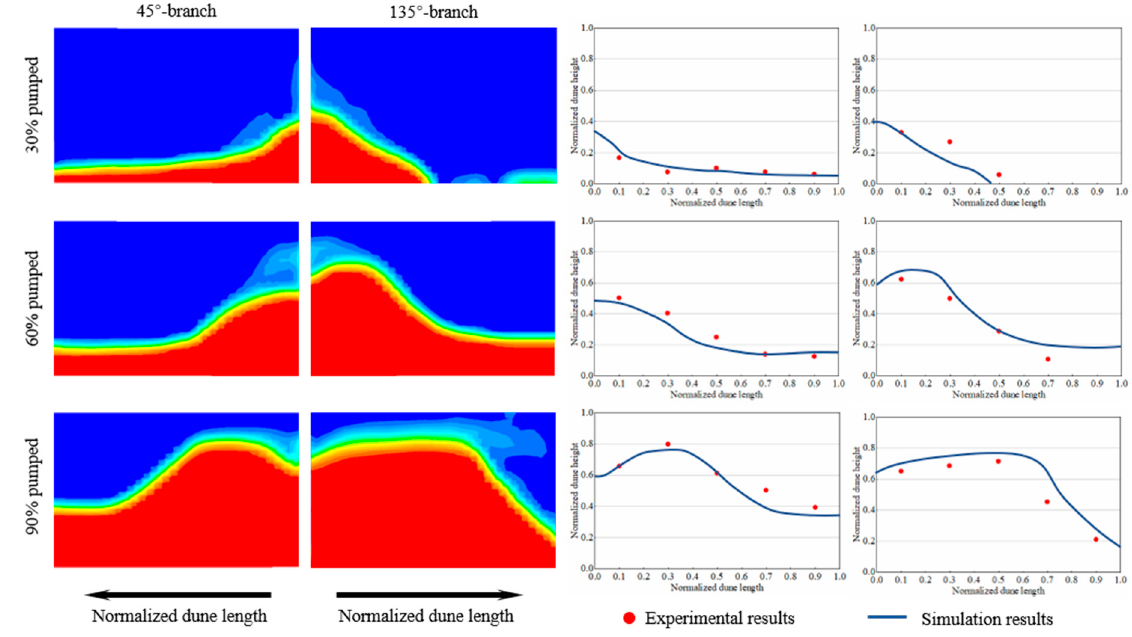
Figure 12. Simulation and experimental results of normalized dune height for case 12.